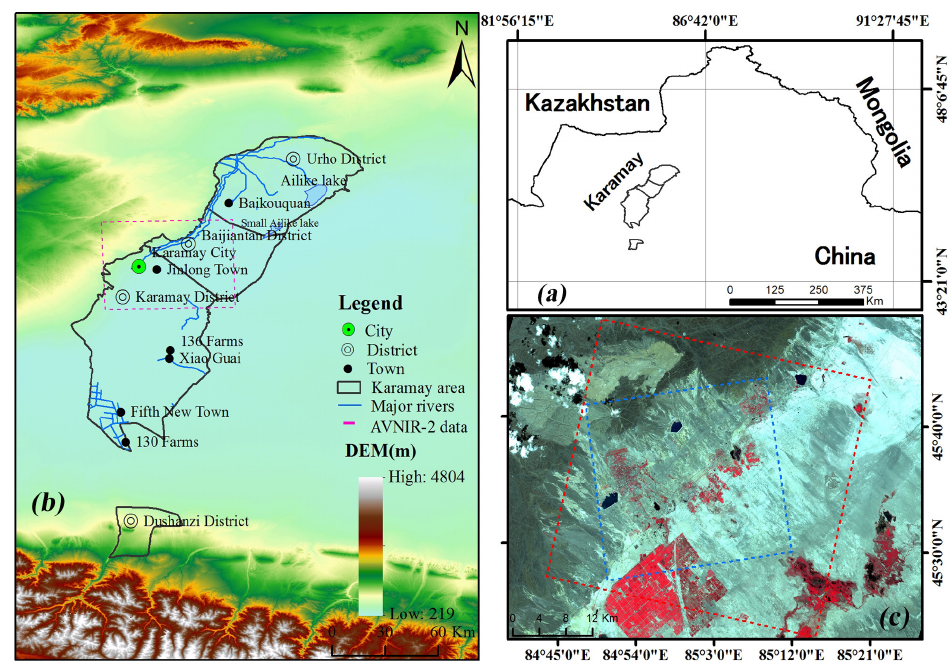
Figure 1. ( a ) Geographic location of the study area; ( b ) Administrative districts of the study area superimposed on the topographic map; ( c ) ALOS ‐ Advanced Visible and Near Infrared Radiometer type 2 (AVNIR ‐ 2) false color composite image of the study area on 15 July 2008. The red and blue dashed lines represent the coverage of ENVISAT ‐ ASAR and ALOS ‐ PALSAR data sets. ALOS: Advanced Land Observing Satellite; ENVISAT: Environmental Satellite; ASAR: Advanced Synthetic Aperture Radar; PALSAR: Phased Array L ‐ band Synthetic Aperture Radar.